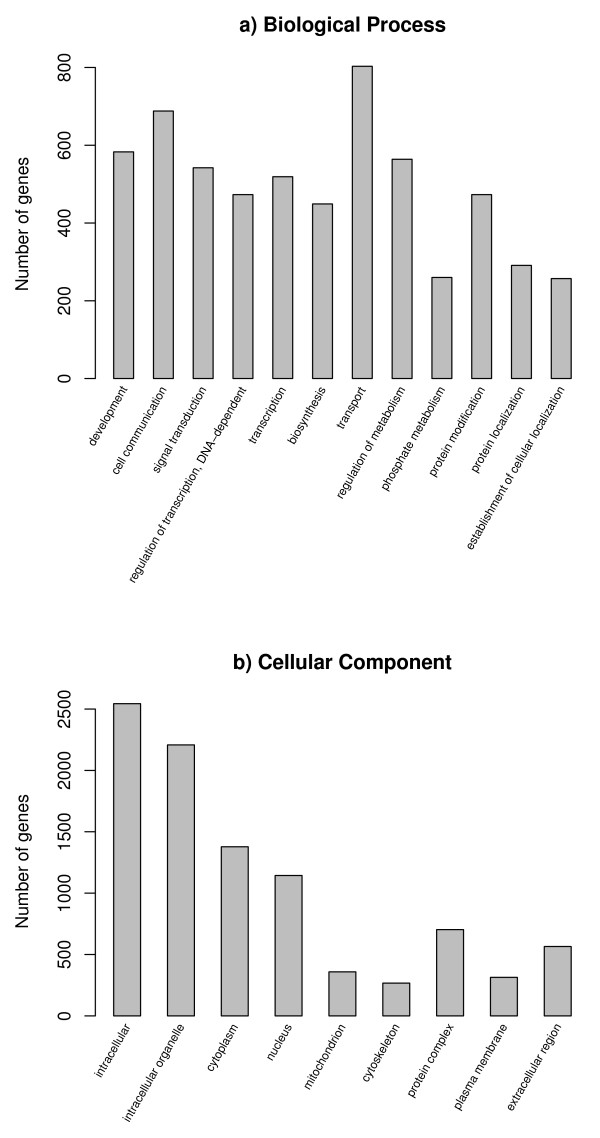
GO analysis. A histogram showing the counts of genes annotated to GO categories for Biological Process and Cellular Component among the 4600 mapped sheep genes for which MGI annotations of putative mouse homologs were available. Terms were selected from among the most frequently annotated and terms deemed to be particularly interesting for fracture healing. a) Terms from the subontology biological process. b) Terms from the subontology cellular component.